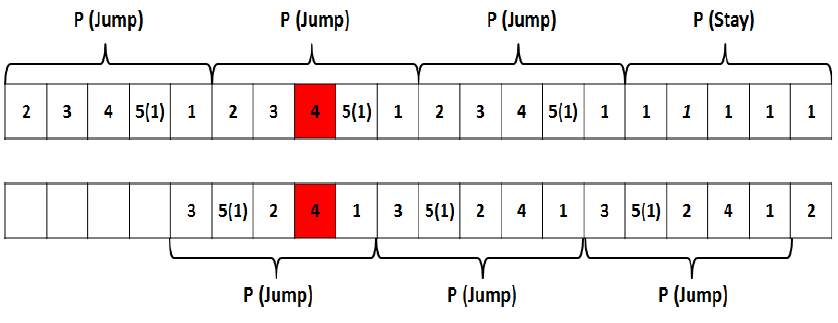
Figure 2. An example of symmetric EJS Algorithm.